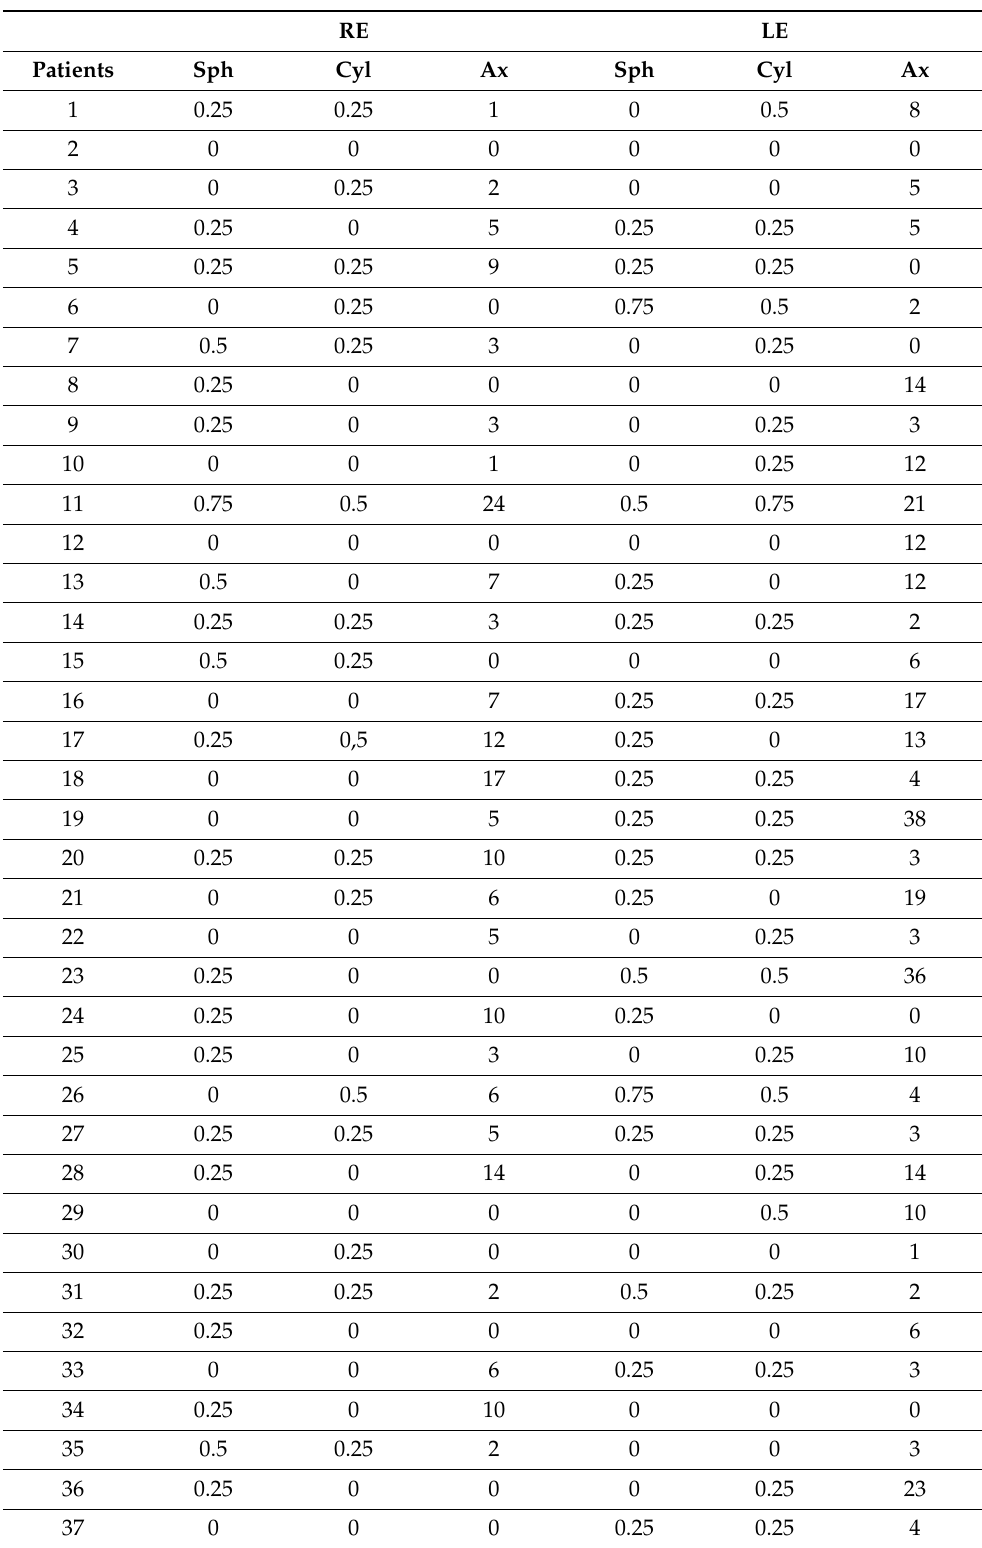
Table 2. Absolute differences between the standing and sitting positions. RE = right eye; LE = left eye; Sph = sphere; Cyl = cylinder; Ax =